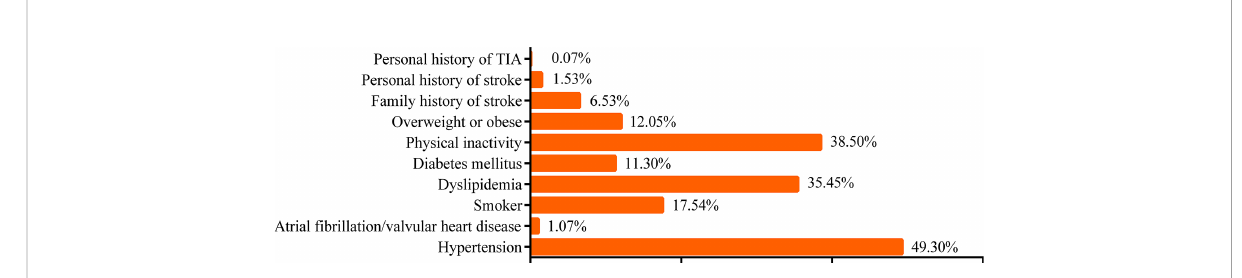
FIGURE 2 Risk factors according to the “ 8+2 ” Stroke Risk Screening Program. TIA , transient ischemic